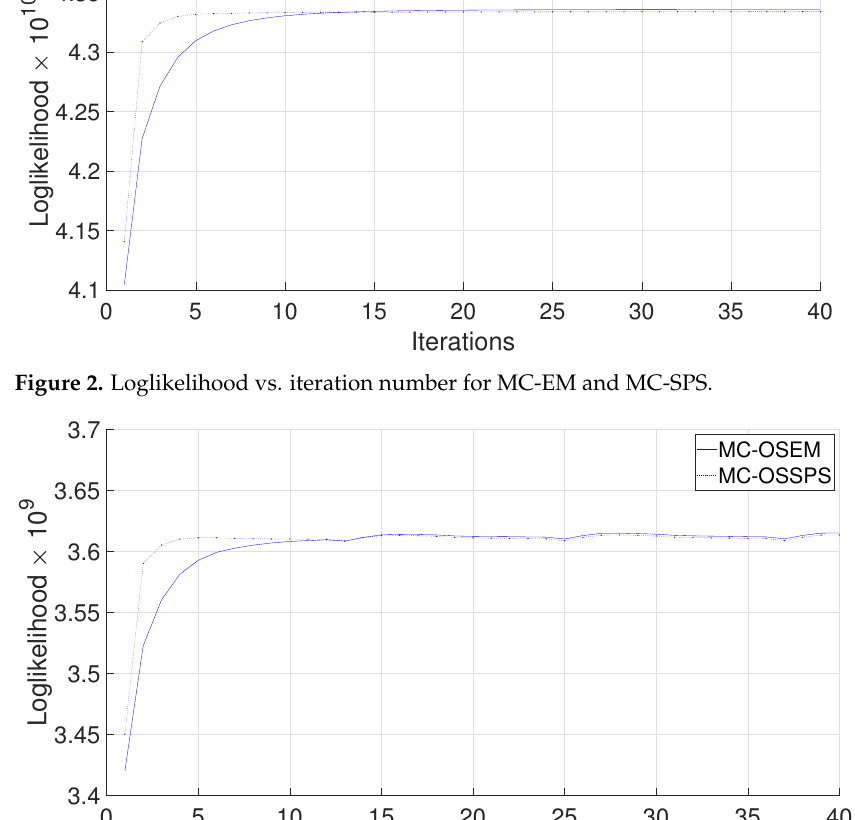
L ( y | λ ) − L ( y | λ n ) LM vs. iteration number for R-MC-OSSPS and L ( y | λ ) − L ( y | λ 0 ) LM